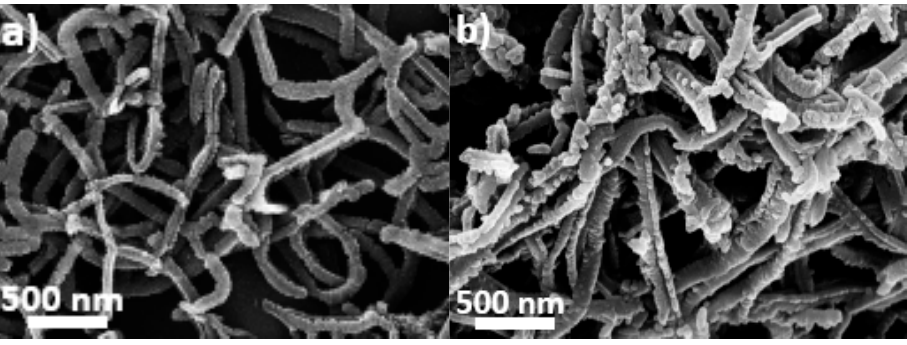
Figure 4. Comparison between the morphologies of PANI s -tubes ( a ) before and ( b ) after heat-treatment at 900